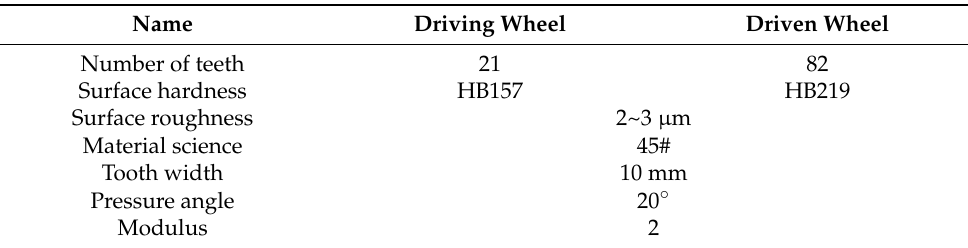
Figure 2. Impact loading mode.